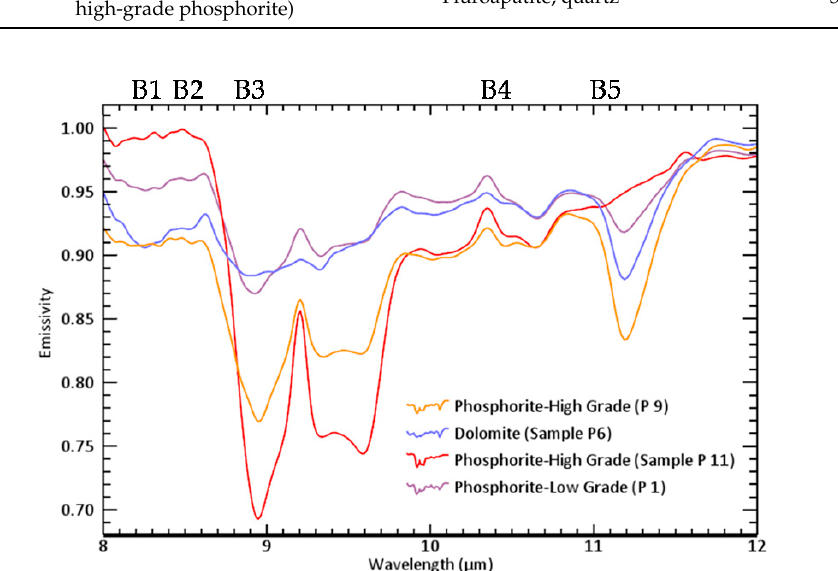
Figure 4. Continuum removed thermal emissivity spectra of representative samples of dolomite and phosphorites (P1 is low-grade; P11 and P9 are medium-to-high-grade phosphorite; P6 is dolomite ). Broad mineralogy of the samples and P 2 O 5 content of the samples are given in Table 2. Wavelength positions of five TIR bands of ASTER are also shown (B1 to B5). Table 2. Results of XRD and X-ray fluorescence (XRF) analysis of representative samples of phosphorite and dolomite to identify the presence of the dominant mineral phases and their relative proportion along with the P 2 O 5 Content [30].